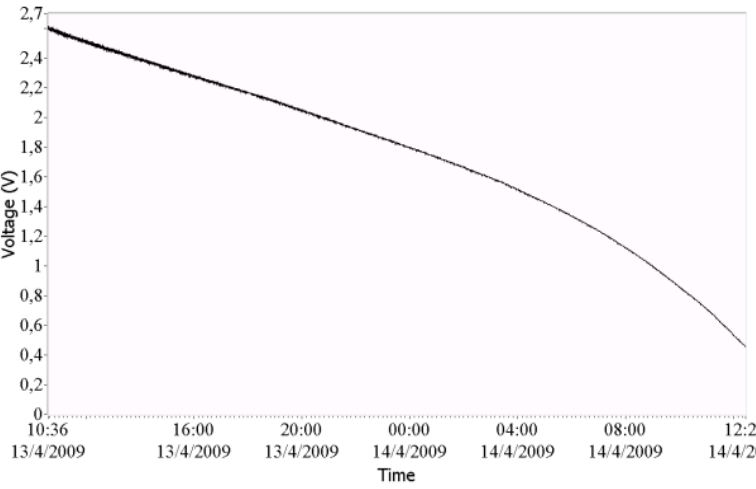
Figure 6. Supply supercapacitor discharge curve of the wEcoValve mote. It has a